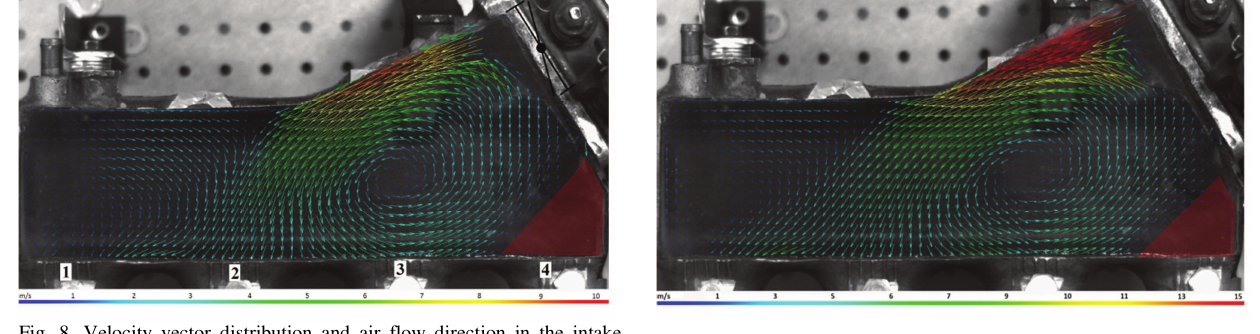
Fig. 9. Velocity vector distribution and air flow direction in the intake manifold at 2000 RPM engine speed and 10˚ throttle position